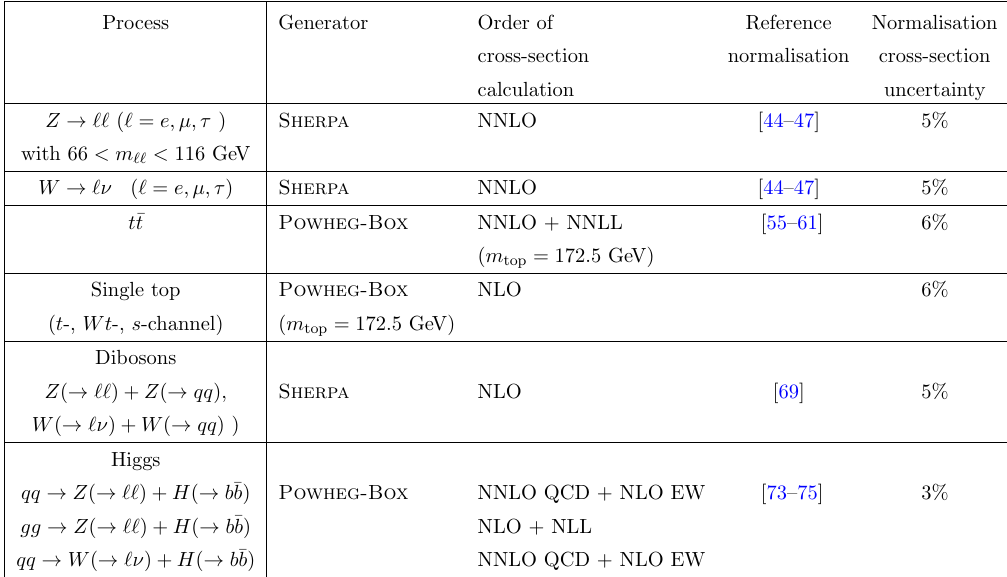
Table 1 . Signal and background MC samples: the generator programs used in the simulation are listed in the second column, the order of the QCD calculation and the reference used for the calculations of the normalisation cross section are reported in the third and fourth columns. The normalisation cross-section uncertainty in the (cid:12)nal column corresponds to PDFs and scale